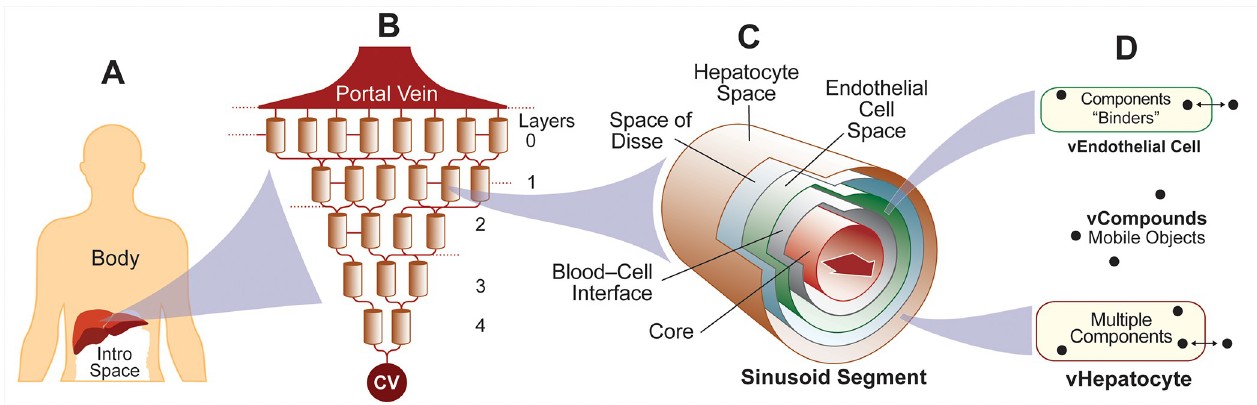
Fig 2. Virtual Human components. (A) A vHuman comprises a well-mixed Body space, a vLiver, and a space for Dose. (B) A portion of vLiver. Graph edges designate flow connections within and between Layers. (C) A multi-layered, quasi-3D Sinusoidal Segment maps to a portion of lobular tissue. It comprises a Core surrounded concentrically by the four 2D grids described in the text. Mobile vCompound objects move within and between these grids. (D) A Sinusoidal Segment contains two Cell types. Each type controls vCompound entry from and exit to an adjacent space. The Cell and the components within determine the fate of vCompounds that enter. We list specification details in S1